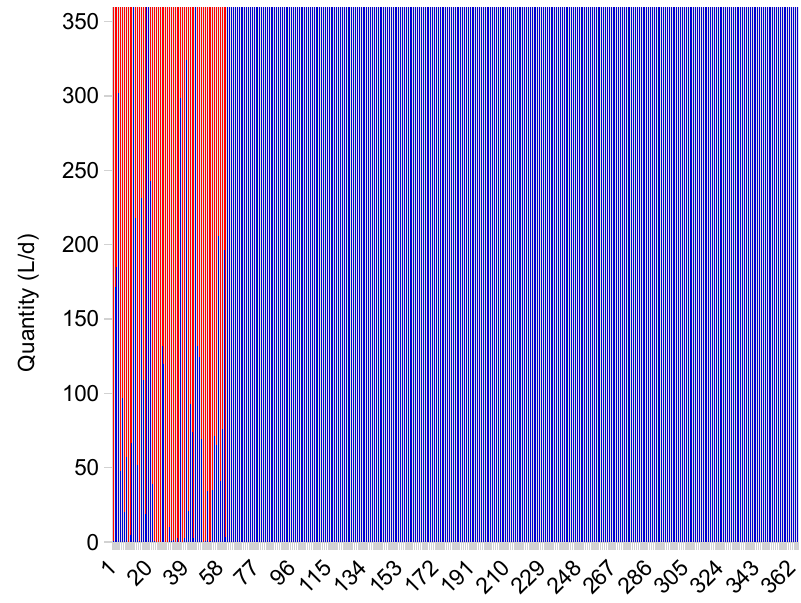
Figure 4. Daily requirements supplied through RWH (blue bars) and the corresponding required supplementary supply (red bars) to meet a demand of 360 L d − 1 for a given family for a catchment area of 100 m 2 . Note that for any given day, the demand that is not met through RWH, is met through supplementary sources to meet the total demand (i.e., 360 L d − 1 ).